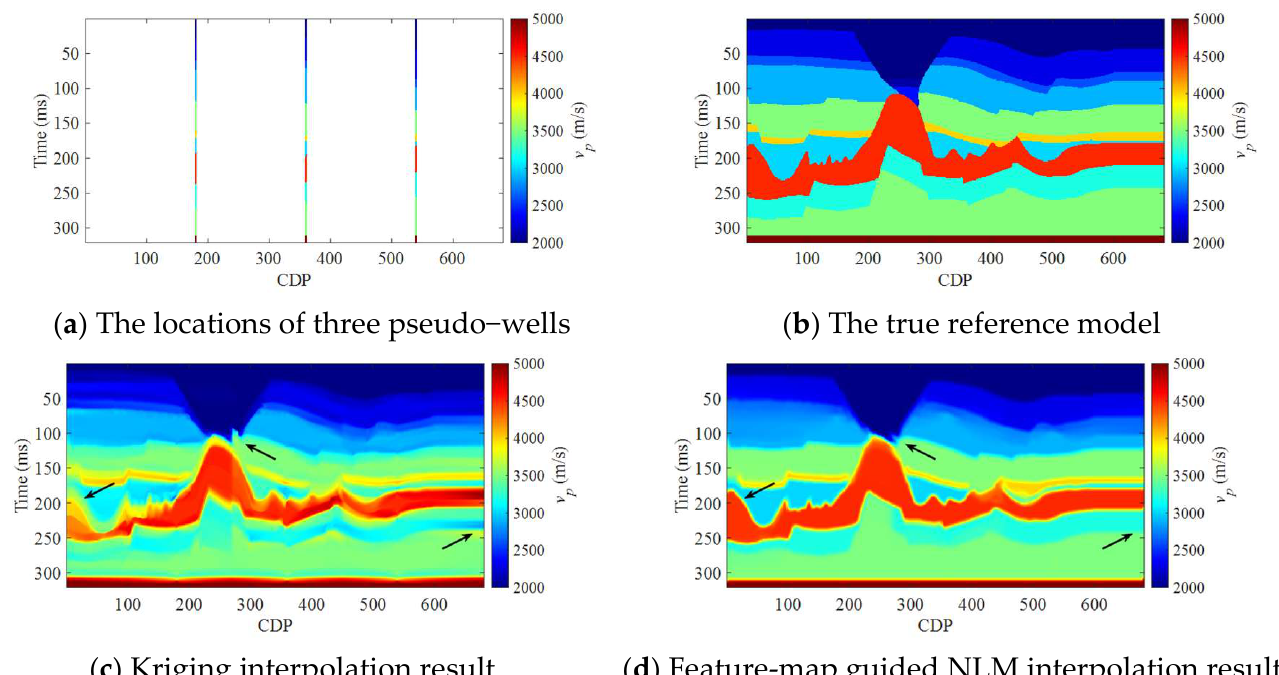
Figure 7. The interpolation results from clean seismic record.